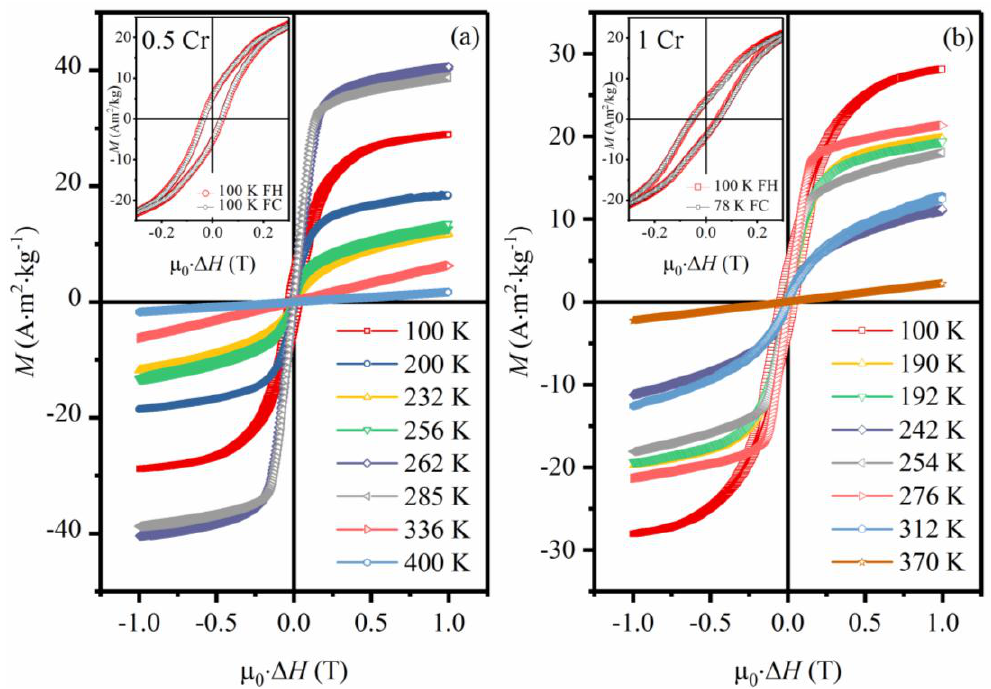
Figure 4. Isothermal magnetisation curves for the 0.5 Cr ( a ) and 1 Cr ( b ) alloys in the temperature range between 100 and 400 K.